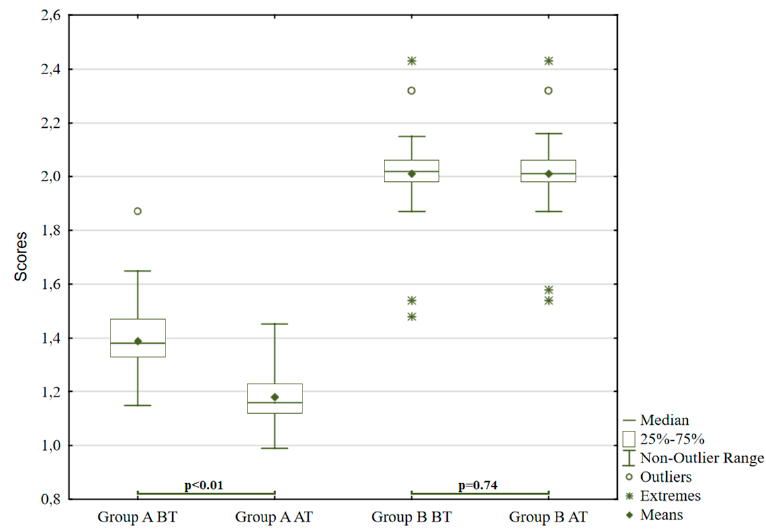
Figure 6. The Hand Test for pathological behavioural phenomena.